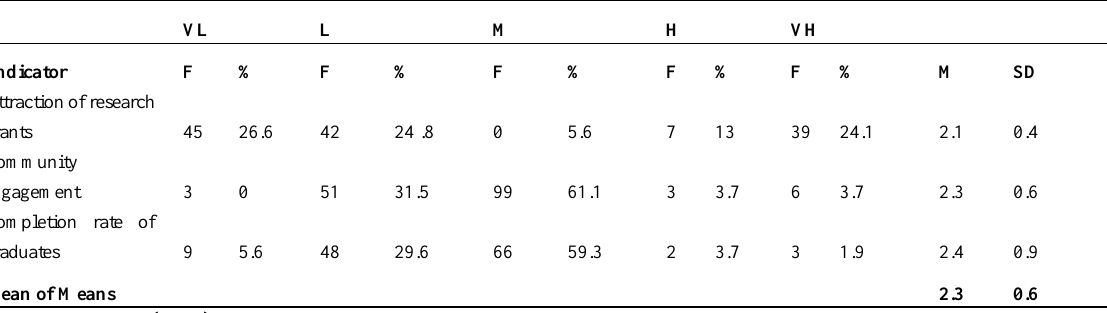
Table 2: Performance of Public